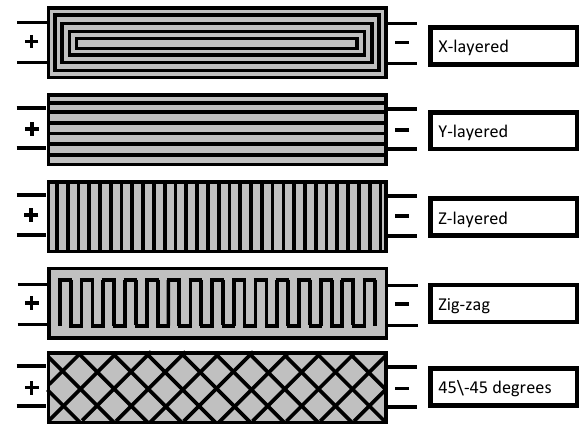
Figure 12. Different beam printing orientations for the resistivity experiments.